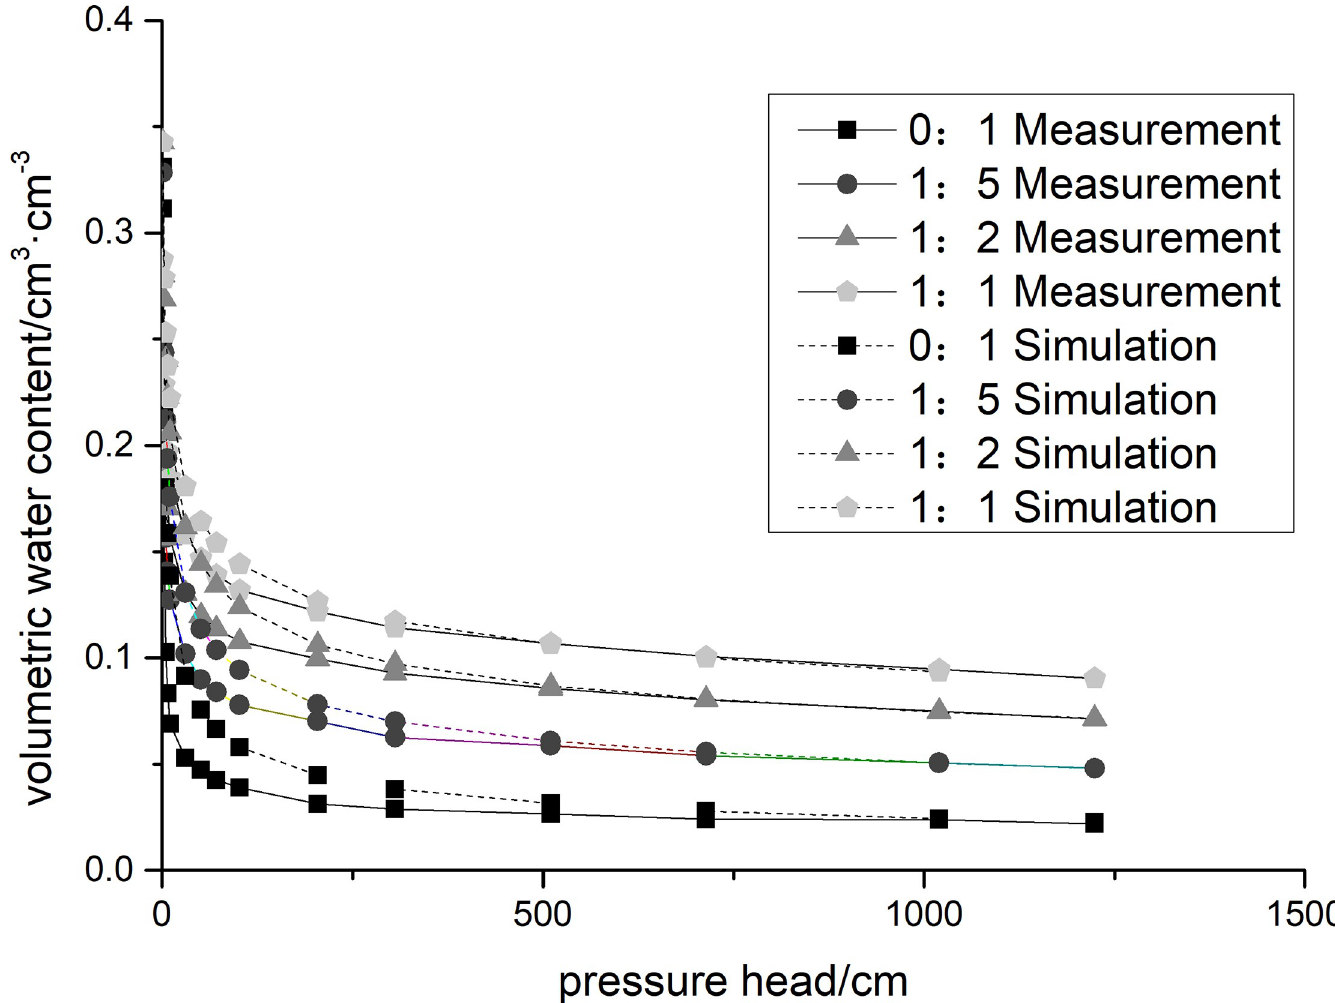
Fig 2. Comparison of predicted and measured soil water characteristic curves after soft rock application.